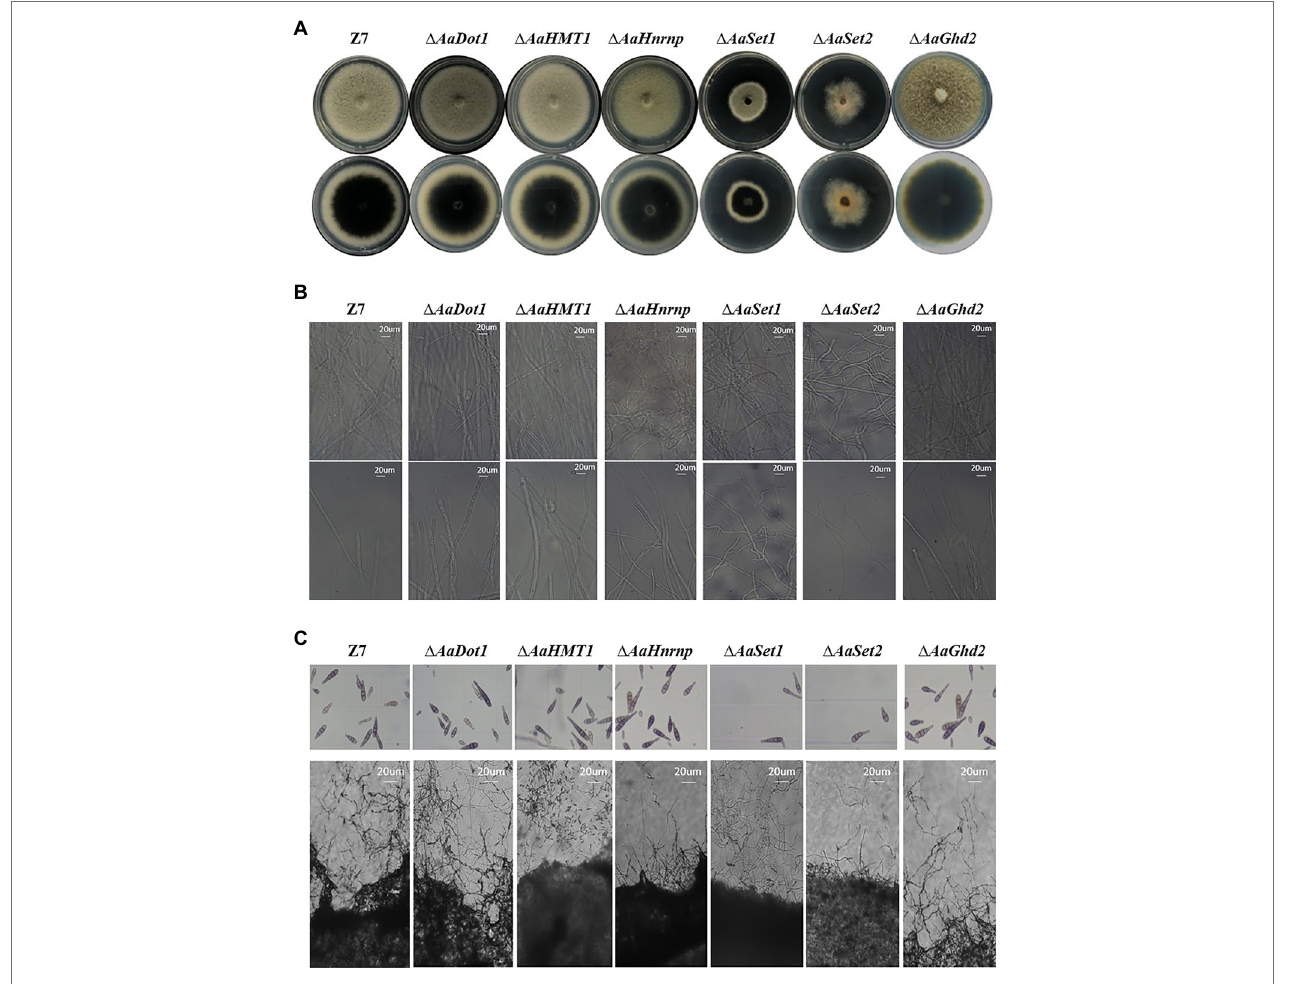
FIGURE 2 | HMTs were required for vegetative growth and fungal development. (A) Radial growth of mutants and wild-type strains 4 days post-incubation. Z7: the wild-type strain. Upper panel shows the back side of the corresponding colonies, and the lower panel shows the front side of the colonies. (B) Hyphae morphology of mutants and wild-type strains. Upper panel represents areas with dense mycelium distribution, and the lower panel represents the mycelium morphology at the edge of corresponding colonies. (C) Conidiation of mutants and wild-type strain. Upper panel represents the eluted spores, and the lower panel represents the spores before